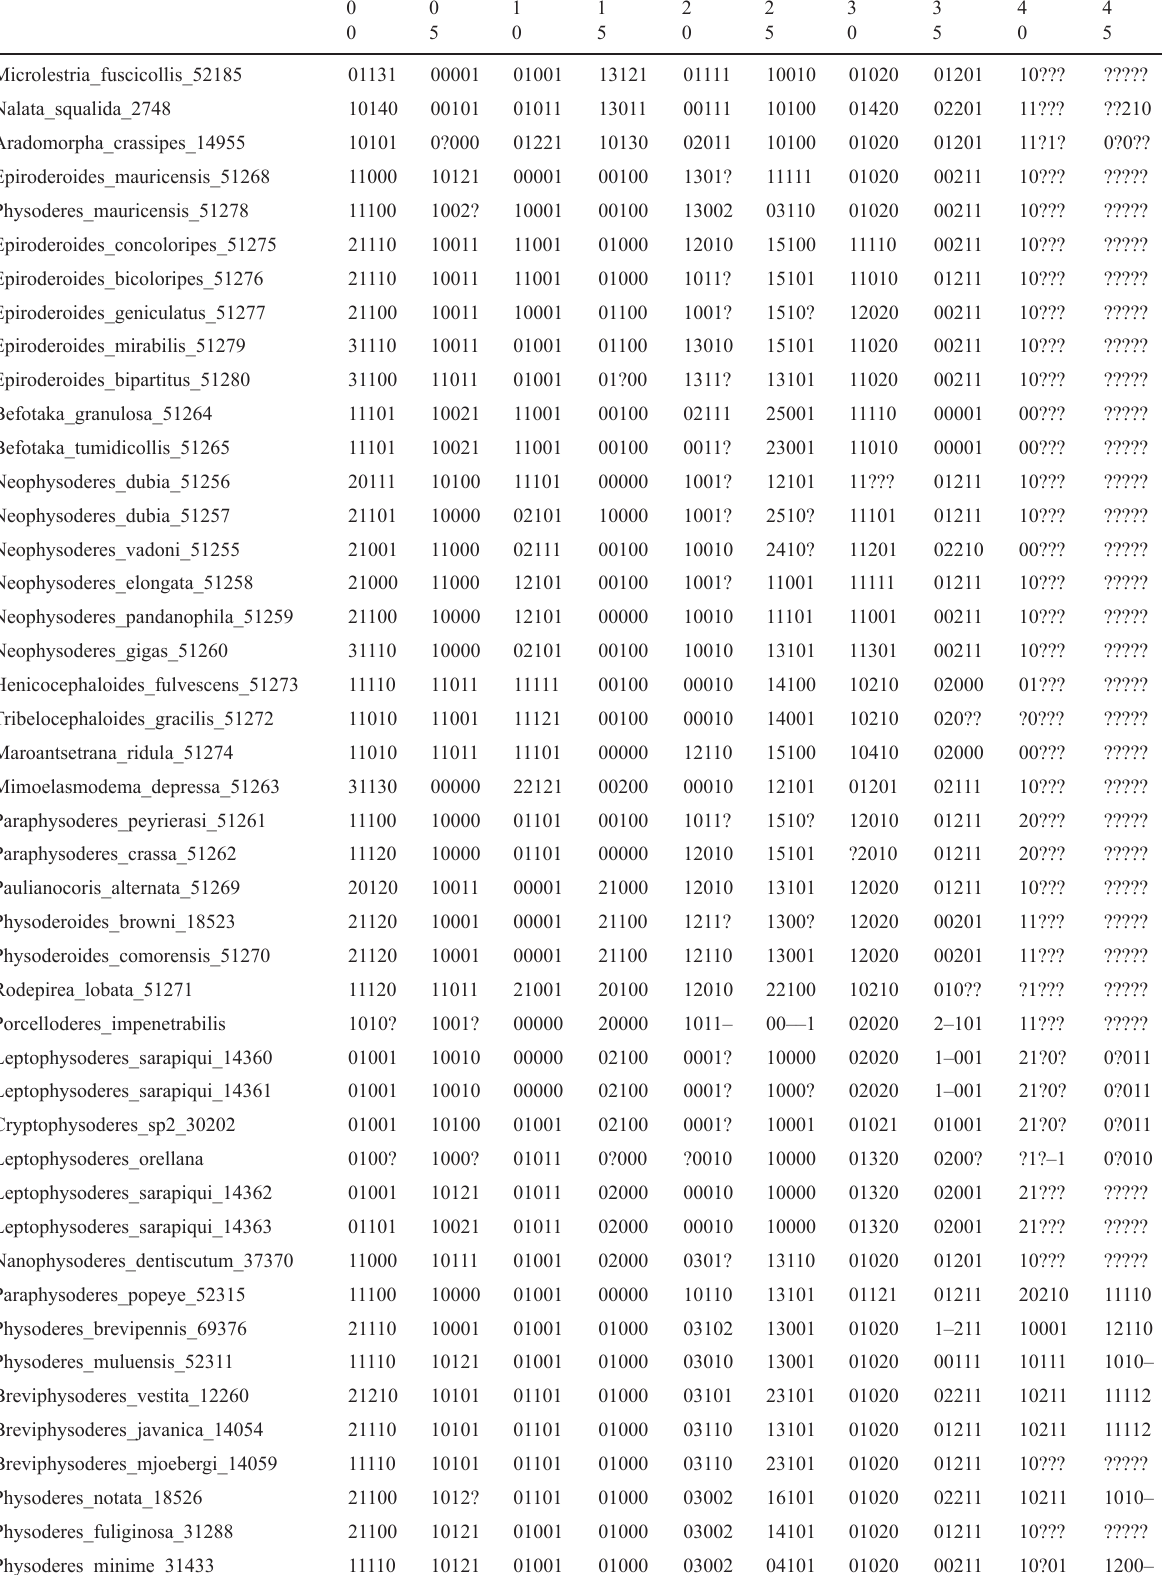
Table 1. Morphological matrix for Physoderinae and outgroup